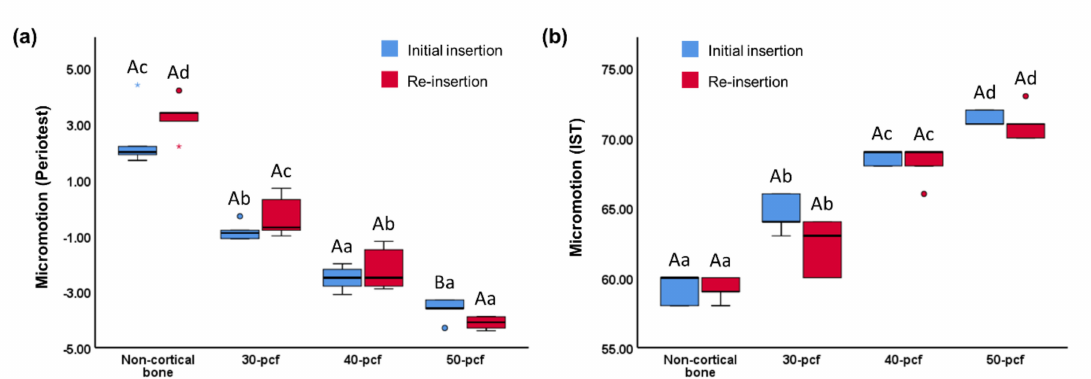
Figure 7. Micromotion values, namely ( a ) periotest value ( b ) implant stability testing value. Di ff erent uppercase letters indicate a significant di ff erence between the initial insertion and re-insertion ( P < 0.05). Di ff erent lowercase letters indicate a significant di ff erence between the various cortical bone densities ( P <